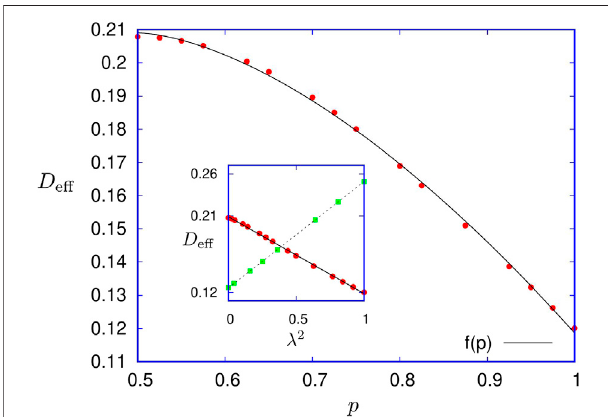
FIGURE 2 | Intensity of the effective noise D eff as a function of p for the SSmodelin2+1dimensions. Thecontinuouscurveisthefunction f ( p ) (cid:2) c 1 − c 2 ( p − q ) φ . Here, φ is the golden ratio, and c 1 and c 2 are adjustable constants. In the inset, we have D eff asa function of λ 2 . The dashed line with apositive slope is for 1+1 dimensions with λ (cid:2) p − q while the other one with a negative slope is for 2+1 dimensions.